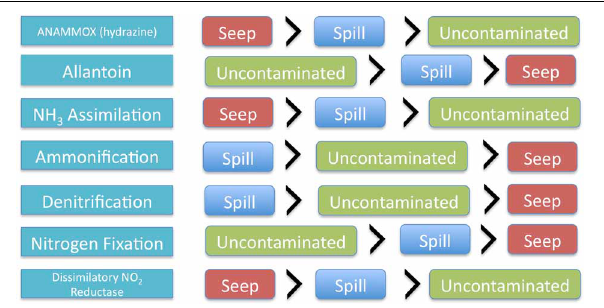
FIGURE 1 | Graphical representation of the changing relative abundance of different key nitrogen pathways and genes within each of the sample